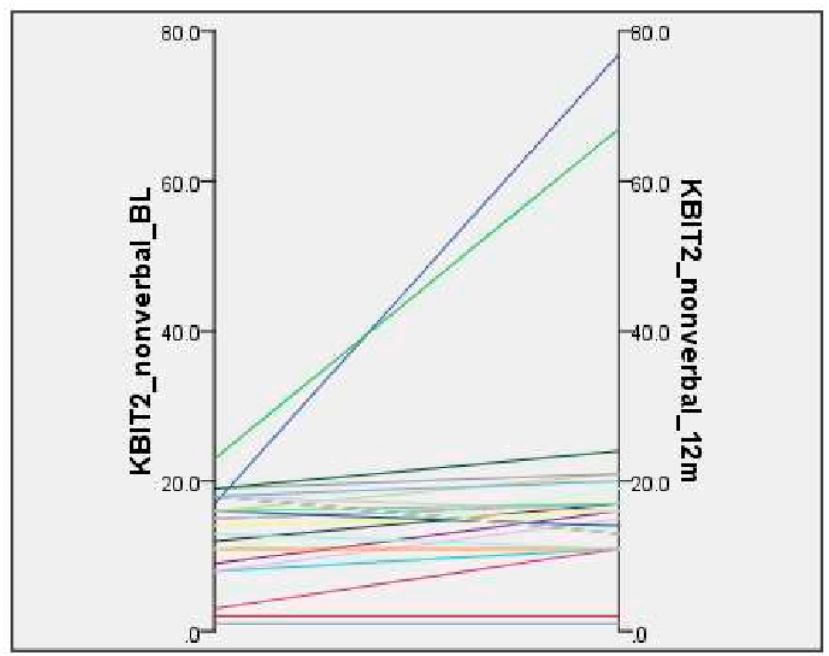
Figure A2. Change in KBIT2 non-verbal scores at 12 months from baseline.